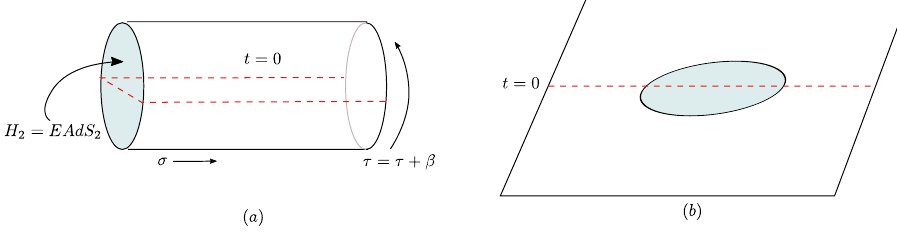
Figure 2 . We prepare the combined thermo(cid:12)eld double state of the black hole and radiation using a Euclidean path integral. These are two pictures for the combined geometry. In (b) we have represented the outside cylinder as the outside of the disk. By cutting along the red dotted line, we get our desired thermo(cid:12)eld double initial state that we can then use for subsequent Lorentzian evolution (forwards or backwards in time) to get the diagram in (cid:12)gure